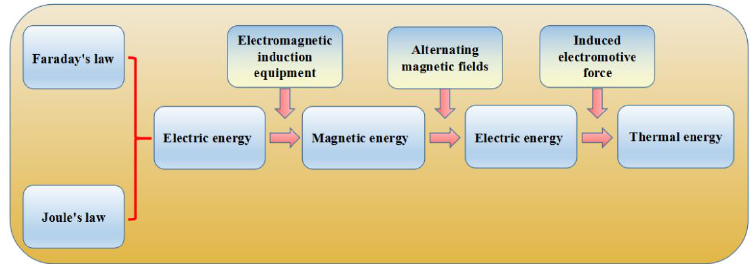
Figure 6. Flow chart of principle of electromagnetic induction heating deicing.